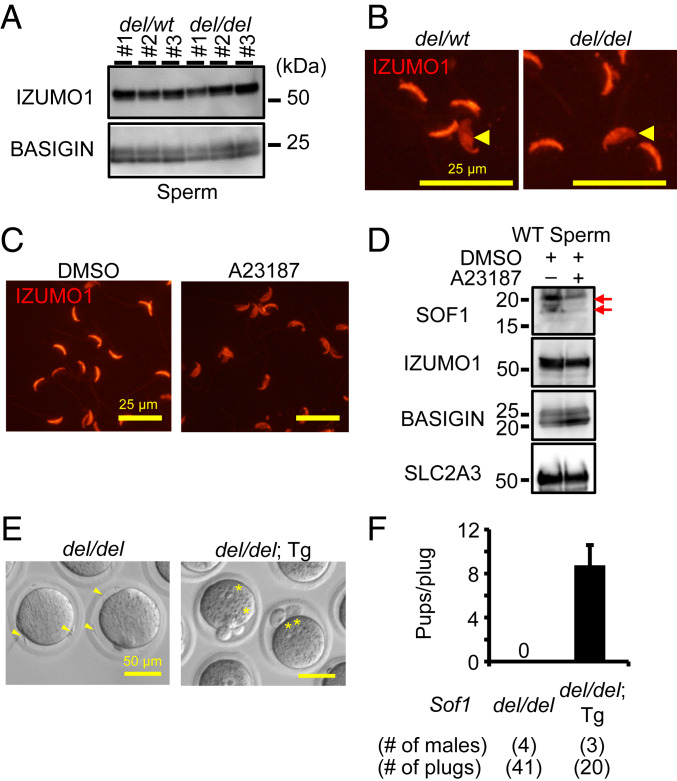
Characterization of Sof1 KO spermatozoa and Tg rescue. (A) Detection of IZUMO1 in spermatozoa. IZUMO1 was detected in Sof1 control and KO spermatozoa at a comparable level. BASIGIN, a sperm tail protein, was used as a loading control. (B) Immunostaining of IZUMO1 in spermatozoa before and after the acrosome reaction. After the acrosome reaction, IZUMO1 in Sof1 KO spermatozoa spread out over the entire head (arrowheads), indicating that the IZUMO1 localization of Sof1 KO spermatozoa is normal. (C) Inducement of sperm acrosome reaction using Ca2+ ionophore A23187. To examine acrosome reaction rates, spermatozoa were stained with an anti-IZUMO1 antibody. DMSO was used as the control. Acrosome reaction rates of spermatozoa treated with DMSO and A23187 were 19.7 ± 10.8% (n = 4) and 83.3 ± 5.5% (n = 4), respectively. (D) Detection of SOF1 in A23187-treated spermatozoa. The doublet bands of SOF1 were detected in spermatozoa treated with DMSO. The lower band disappeared in A23187-treated spermatozoa, but the upper band remained. There was no significant difference in the amount of IZUMO1 between DMSO- and A23187-treated spermatozoa, in agreement to the previous report (10). BASIGIN and SLC2A3, which are mainly localized in sperm tail, were used as the control. (E) Oocyte observation of females mated with Sof1 del/del males having the Sof1-PA Tg insertion. Sof1 KO spermatozoa were accumulated in the perivitelline space (arrowheads), but spermatozoa of Sof1-PA Tg rescued Sof1 del/del males (del/del; Tg) could fertilize oocytes (asterisks) (2 PN rates: 0% [del/del, 109 oocytes, n = 3], 100% [del/del; Tg, 39 oocytes, n = 3]). (F) Male fecundity of Sof1-PA Tg rescue mice. Each male was caged with two wt/wt females for more than 1 mo. The females mated with Sof1-PA Tg rescue males could deliver offspring (pups/plug: 0 [del/del], 8.7 ± 1.8 [del/del; Tg]). The litter sizes of Sof1 del/del and Sof1-PA Tg rescue males were 0 and 10.2 ± 0.5, respectively. The data of fecundity in Sof1 del/del males were reused data of Fig. 1D.